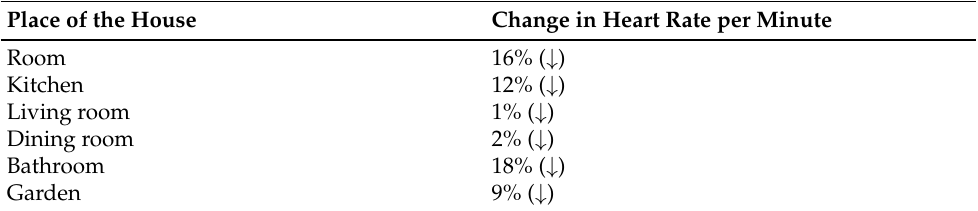
Table 4. Change in person’s average heart rate per minute at each location in house.